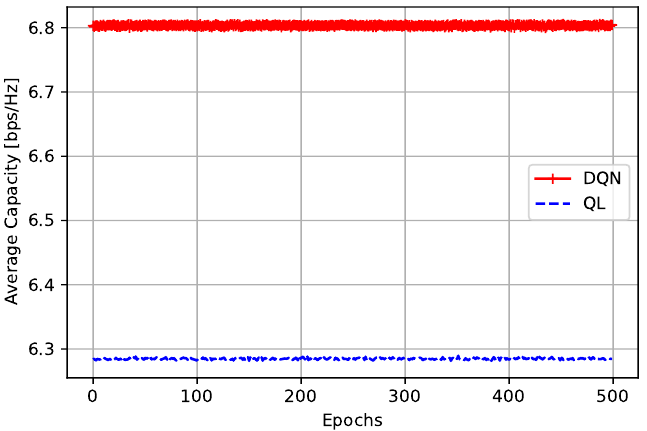
Figure 6. Obtained capacity in evaluation